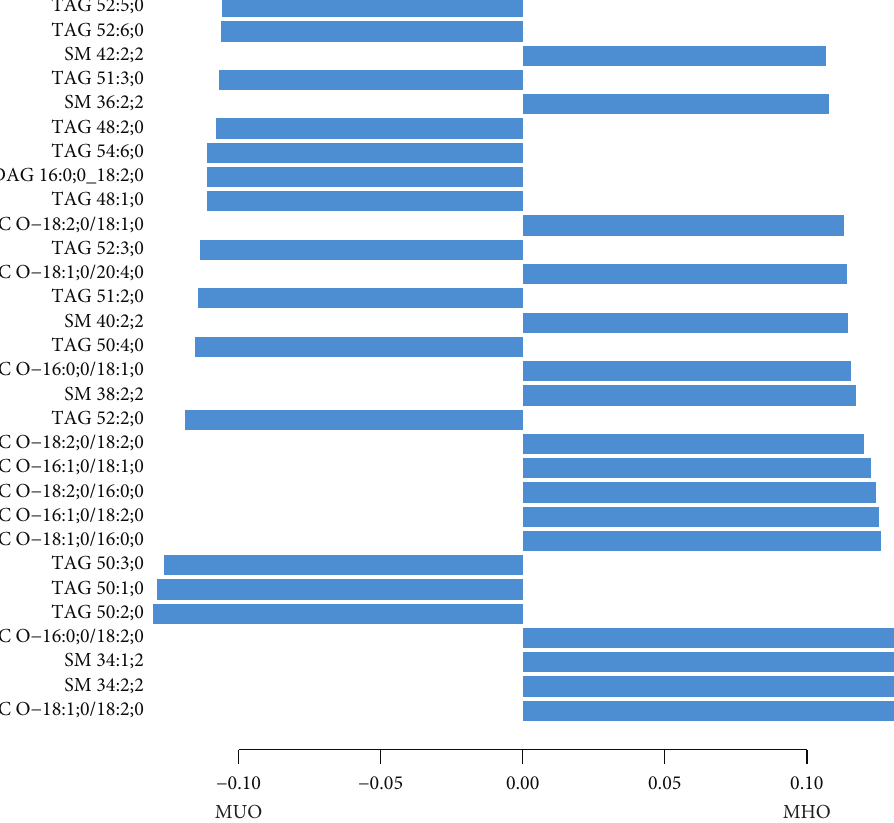
Figure 4: Main loadings for PP5, when comparing MHO with